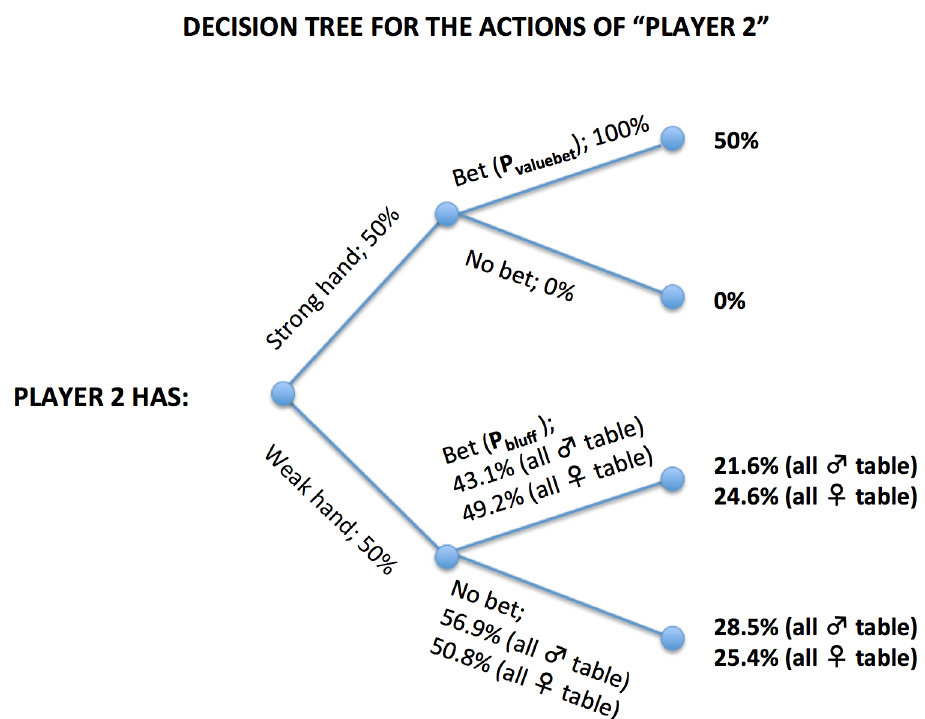
Fig 2. Decision tree for the actions of player 2. The probabilities for “ Strong hand ” and “ Weak hand ” are derived from Assumption 2, and the probability for P valuebet is derived from Assumption 3. The probabilities for P bluff are obtained from our experimental data. “ All ♂ table ” and “ All ♀ table ” refer to the experimental conditions “ all male table ” and “ all female table ” , respectively.